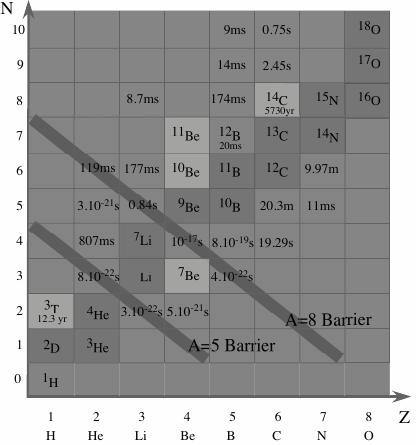
Figure 8.2: The A=12 nuclei system. The diagram explains why of all nuclei with 12 protons and neu- trons, the 12 C is the most stable one. The other nu- clei with A=12 are all unstable and decay via  + or   into 12 C . The energies above the ground state of carbon are given in MeV. Also given the half-lifetime of the unstable nuclei. After Ajzenberg-Selove and Lauritsen 2008.